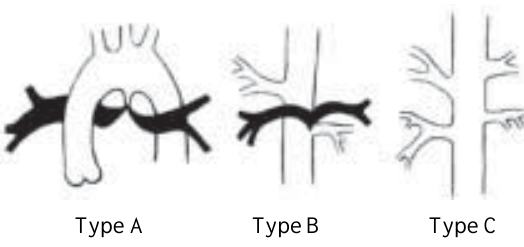
Fig. 1 - Barbero-Marcial classification for the pulmonary vascular blood supply in pulmonary atresia with interventricular communication